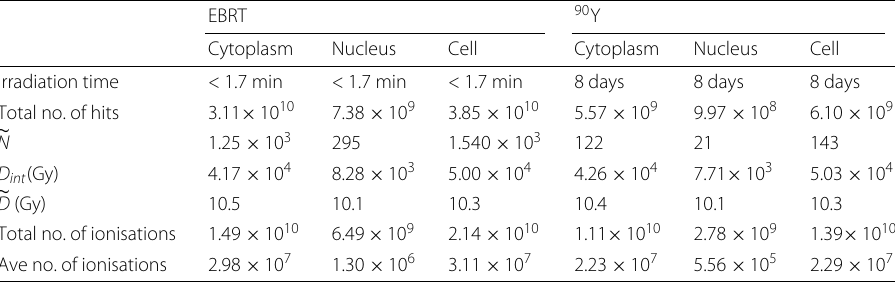
Table 2 Summary of GATE simulation results for EBRT and 90 Y